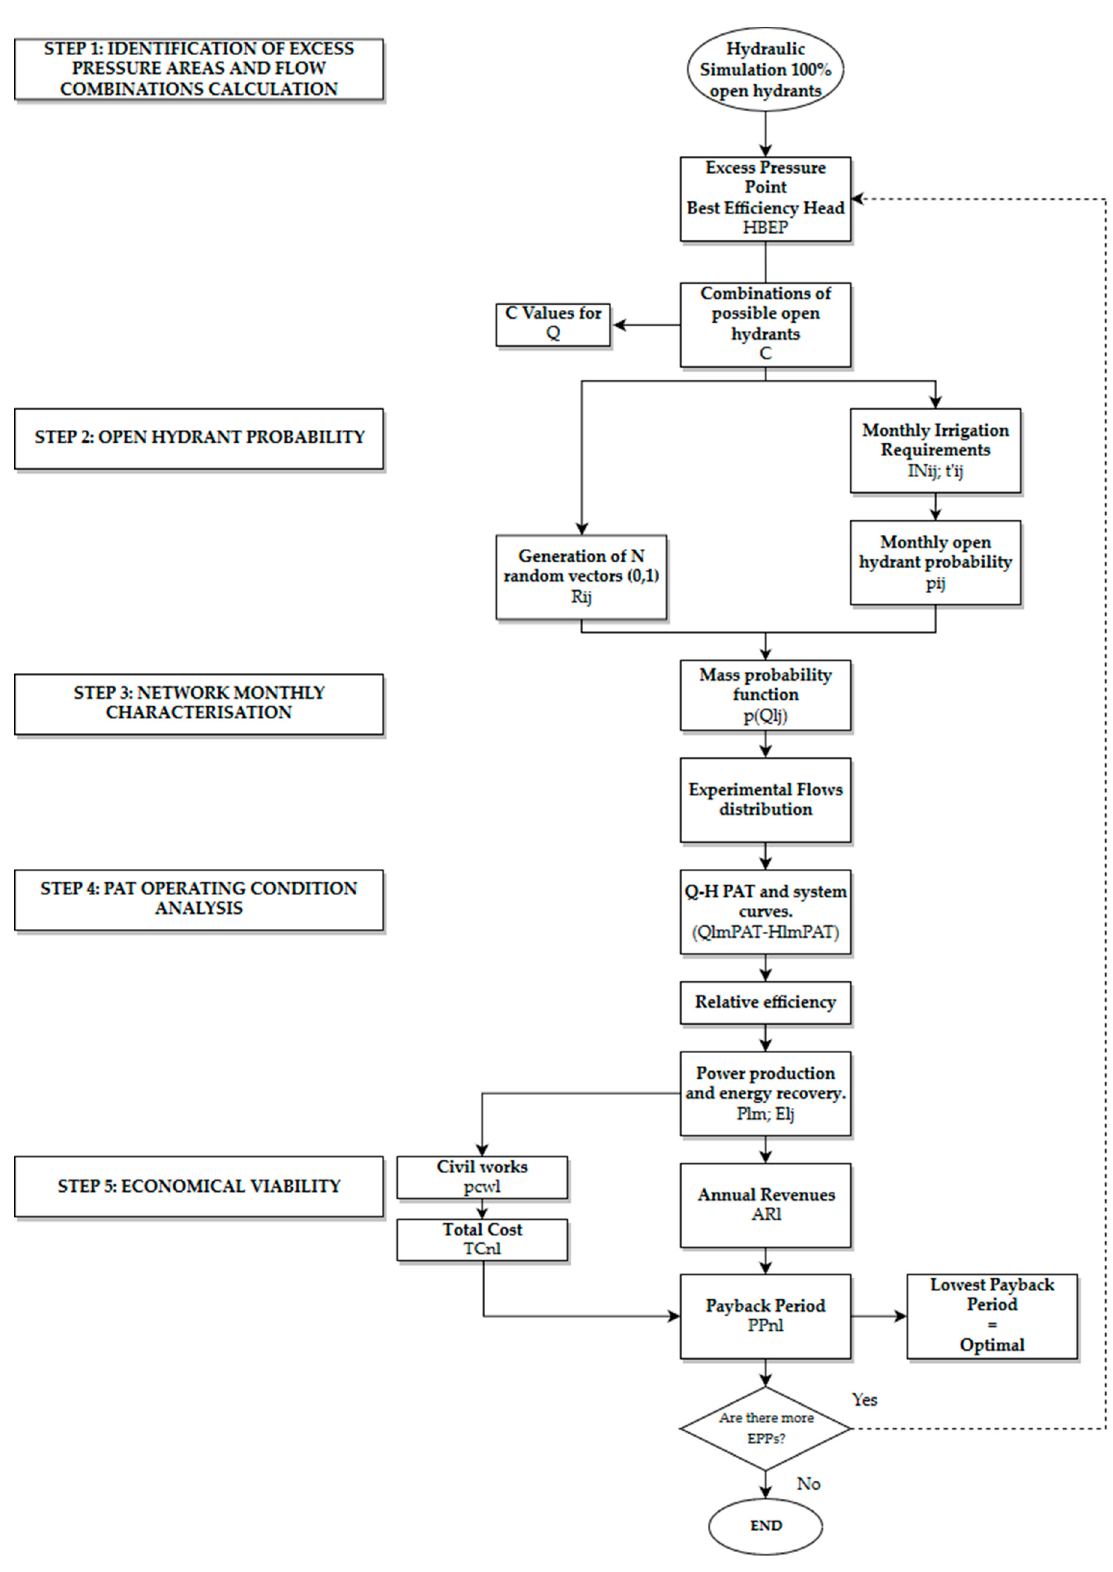
Figure 1. Flowchart of the methodology.